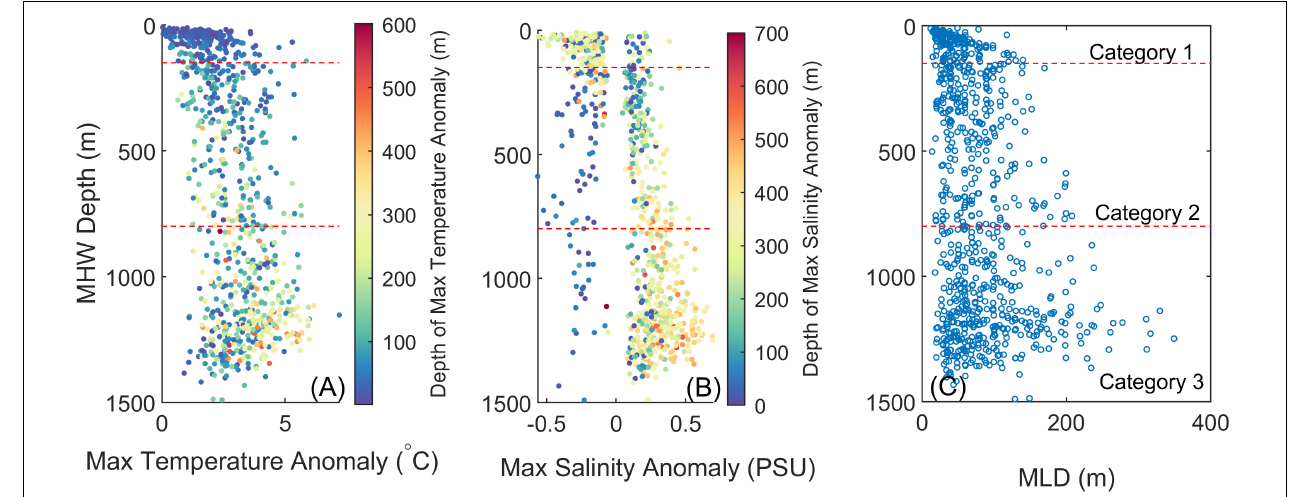
FIGURE 10 | Scatter plots of MHW depth against (A) maximum temperature anomaly, (B) extremum salinity anomaly and (C) MLD. Colors in panel (A,C) show the depth where the extrema